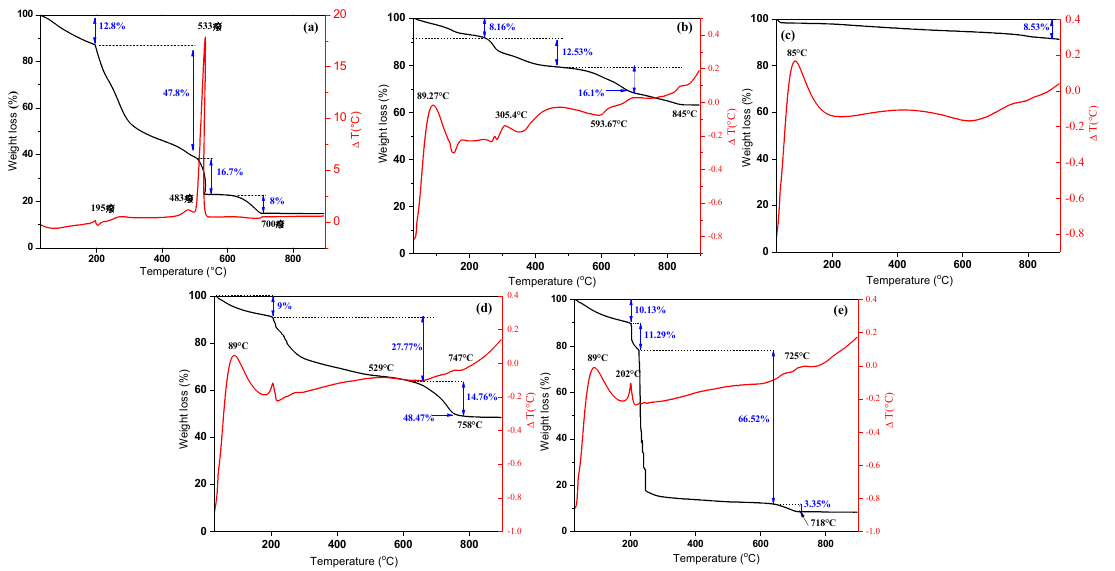
Figure 3. TGA / DTG profiles of ( a ) alginate, ( b ) γ -Fe 2 O 3 particles, ( c ) f-CNT, (d) A / γ -Fe 2 O 3 , ( e ) A / γ - Figure 3. TGA/DTG profiles of ( a ) alginate, ( b ) γ -Fe 2 O 3 particles, ( c ) f-CNT, (d) A/ γ -Fe 2 O 3 , ( e ) A/ γ - Fe 2 O 3 / f-CNT Fe 2 O 3 /f-CNT beads.